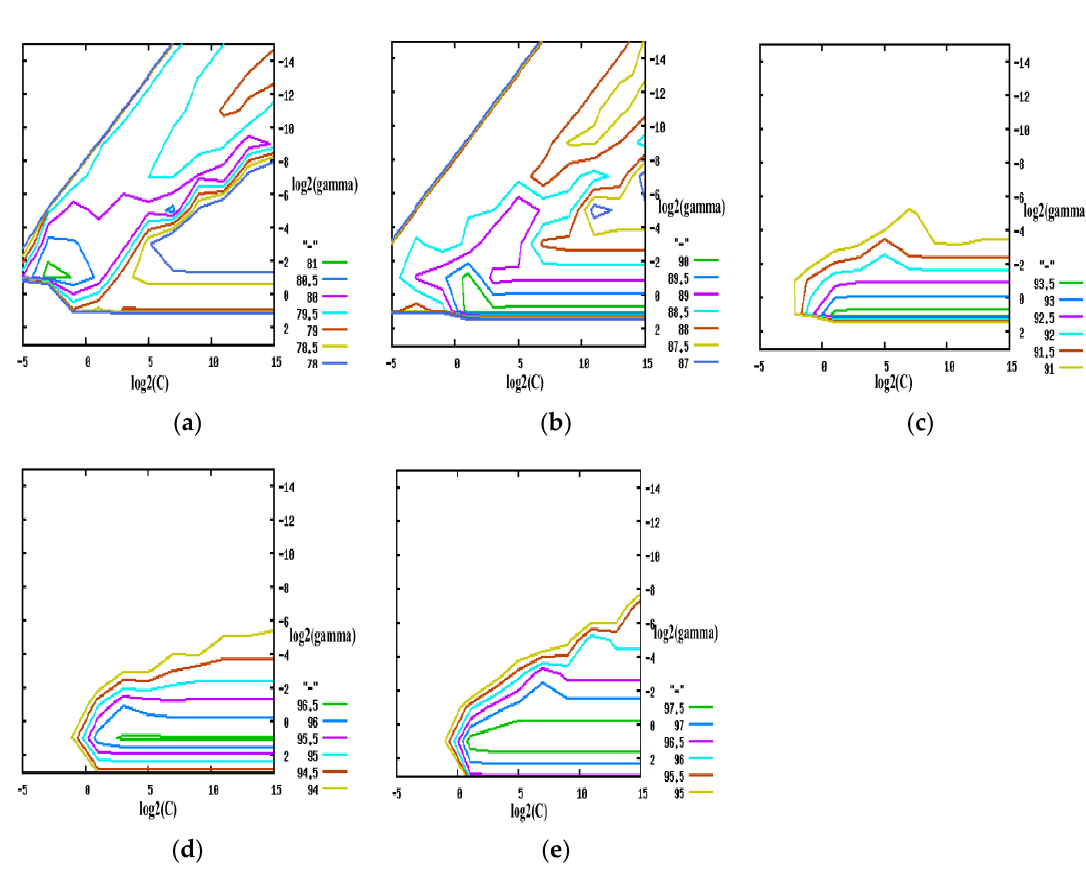
Figure 15. Contour line of the classification accuracy. ( a ) r = 0; ( b ) r = 1; ( c ) r = 2; ( d ) r = 3; ( e ) r = 4.